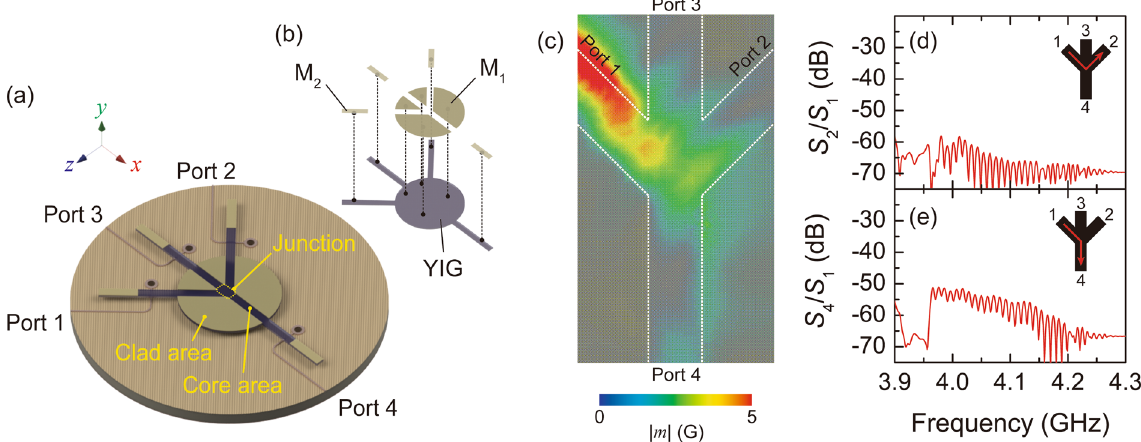
Figure 5. Ψ -shaped interferometer composed of core-cladding waveguide. ( a ) Schematic illustration of the interferometer. The centre of the interferometer is composed of disk-shaped YIG comprised of core-cladding waveguide. ( b ) Detail of waveguide structure. M 1 represents 100-nm-thick gold forming a clad area. M 2 represents 10-nm-thick gold to attenuate backscattered waves. All gold films cover a single surface of YIG film, and the uncovered side is facing the microstrip lines. ( c ) Simulated flow of the spin wave injected from port 1 with H 0 = 3095 Oe. Simulated transmission properties of ( d ) S 2 / S 1 and ( e ) S 4 / S 1 . Inset pictures illustrate the flow of spin waves within the